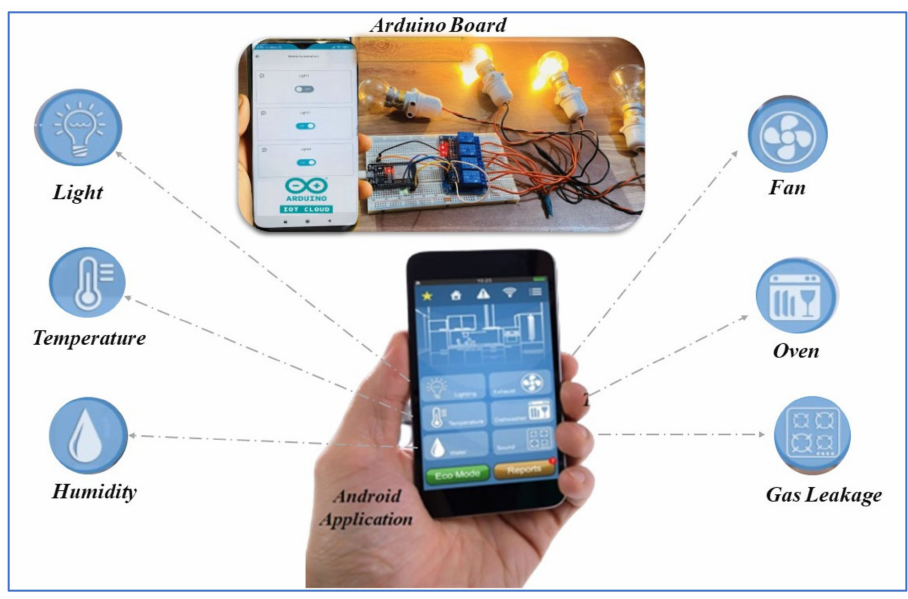
Figure 1. Proposed automation and monitoring system.